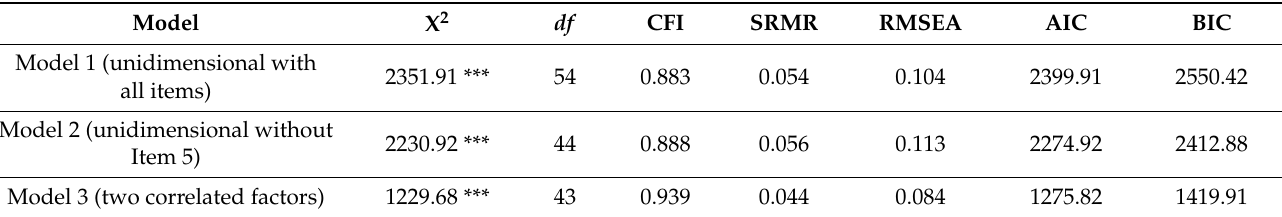
Table 6. The statistics for the fit of the tested models of the